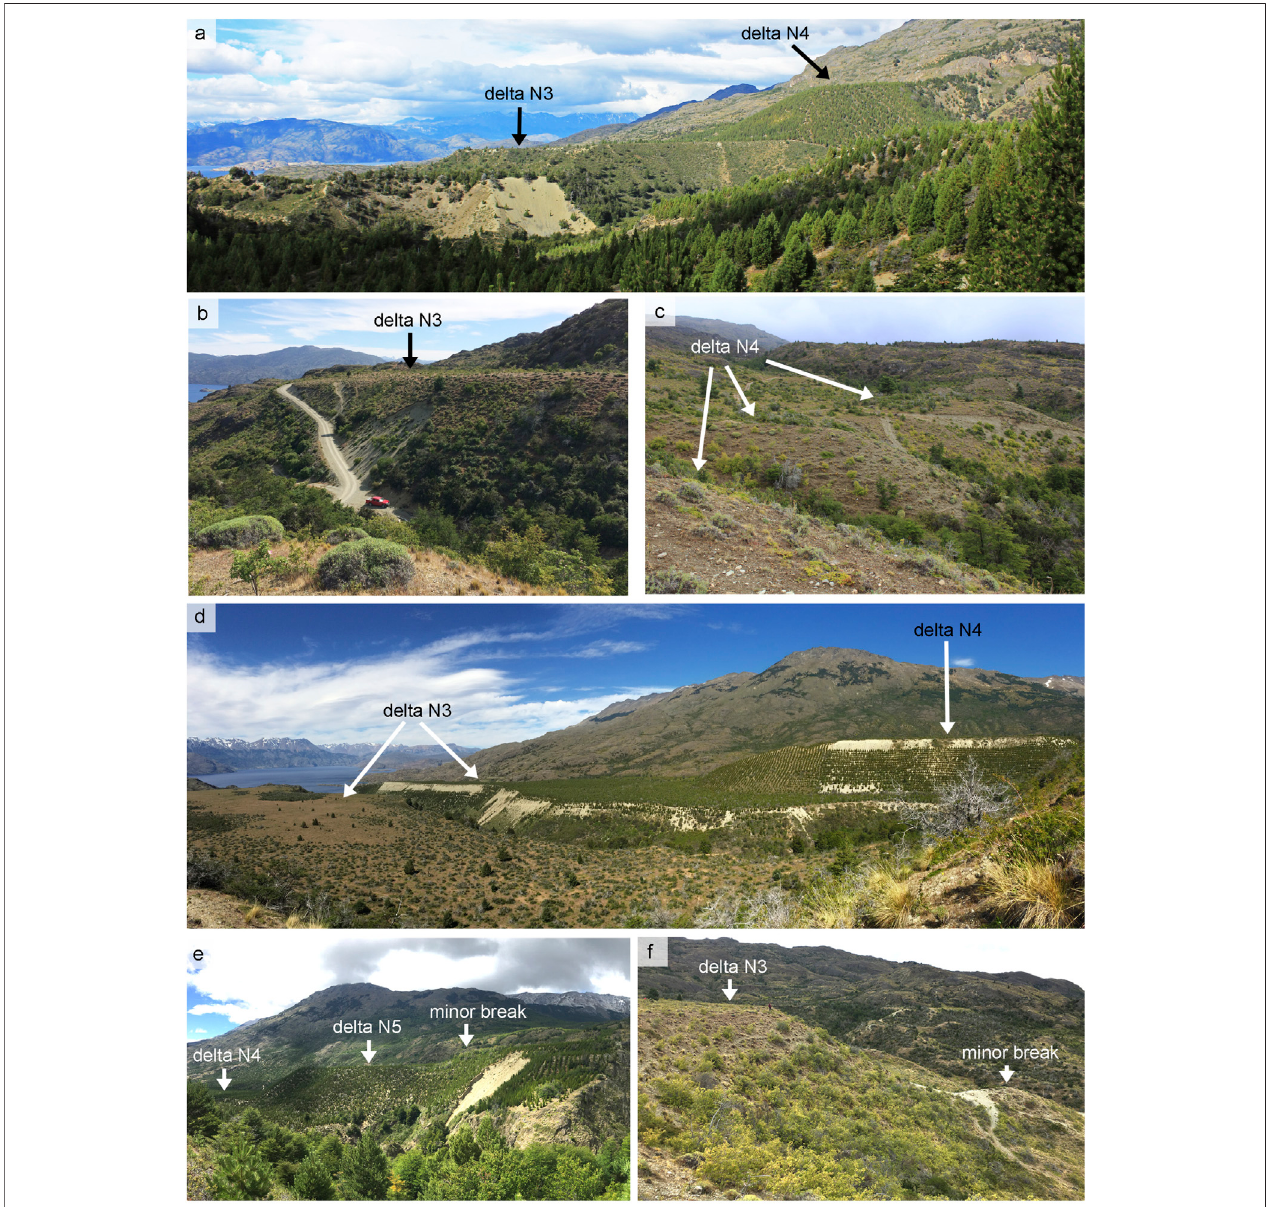
FIGURE 4 | Field photographs from La Ponderosa (A) , Frutillar (B,C) , and Dos Arroyos (D – F) deltas. The location of these sites is expressed in Supplementary Figure S7 .